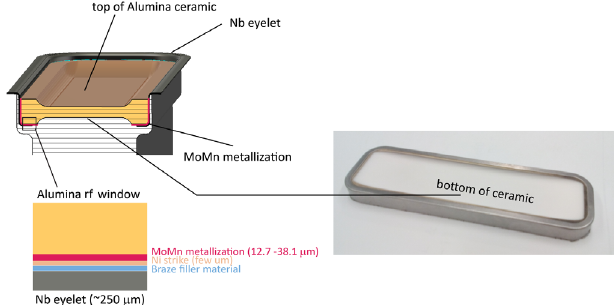
FIG. 5. Cross-sectional illustration (top left) and picture (right) of a standard cold rf ceramic windows as brazed to a Nb eyelet [1]. The bottom left figure illustrates the various layers of material